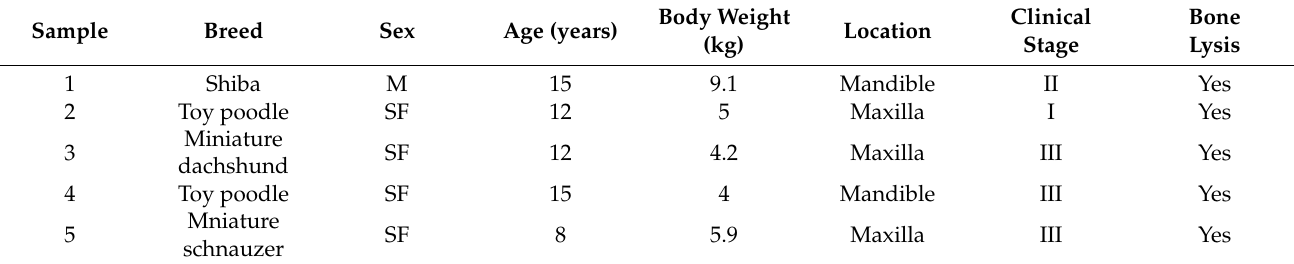
Table 3. The characteristics of the samples used for IHC.